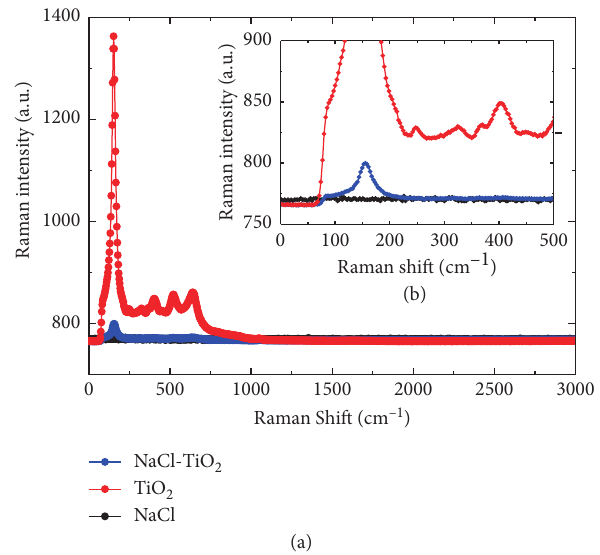
2 and (b) NaCl-SiO 2 .